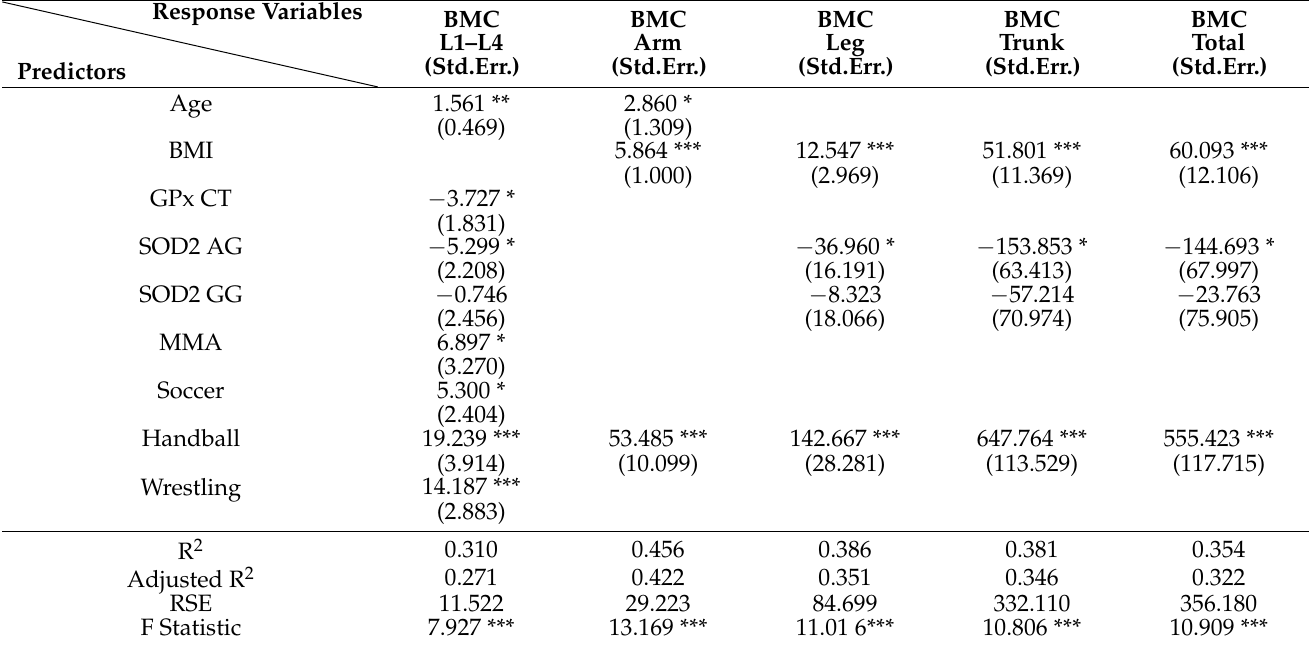
Table 4. Regression models of BMC.